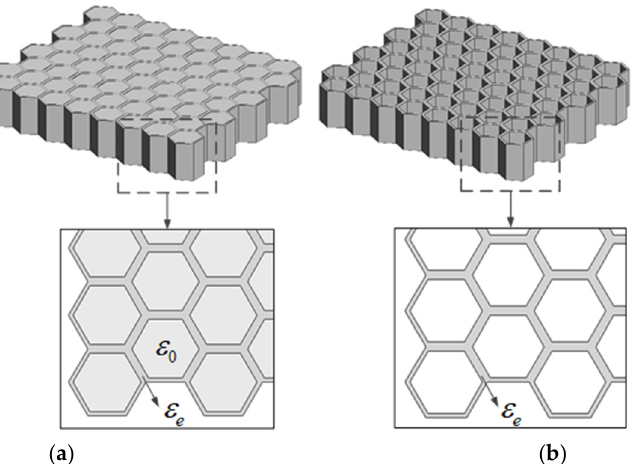
Figure 3. Illustration of different models: ( a ) inhomogeneous unit cell for FE-BI; ( b ) homogenous frame for MoM.